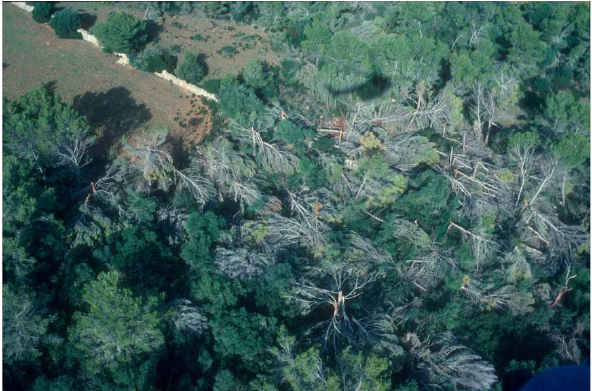
Figure 1. Example of the impacts produced by a downburst: diffluent damages to trees caused Fig. 1. Example of the impacts produced by a downburst: diffluent by a microburst (a small downburst) embedded in a wide downburst produced on September damages to trees caused by a microburst (a small downburst) em- 9th, 1992, in Ciutadella de Menorca (Spain), and seen from helicopter survey (photo © Miquel Gayà) bedded in a wide downburst produced on 9 September 1992, in Ciu- tadella de Menorca (Spain), and seen from helicopter survey (photo © Miquel Gay`a)